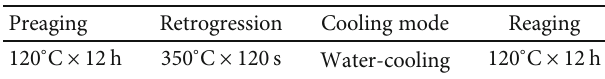
Figure 1: Process diagram of the impact jet solid-liquid compound casting. Table 2: Process parameters of